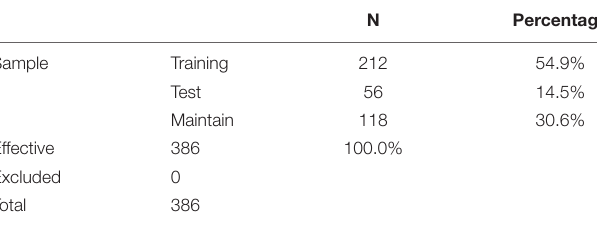
TABLE 1 | Summary table of case processing of BP artificial neural network evaluation model.